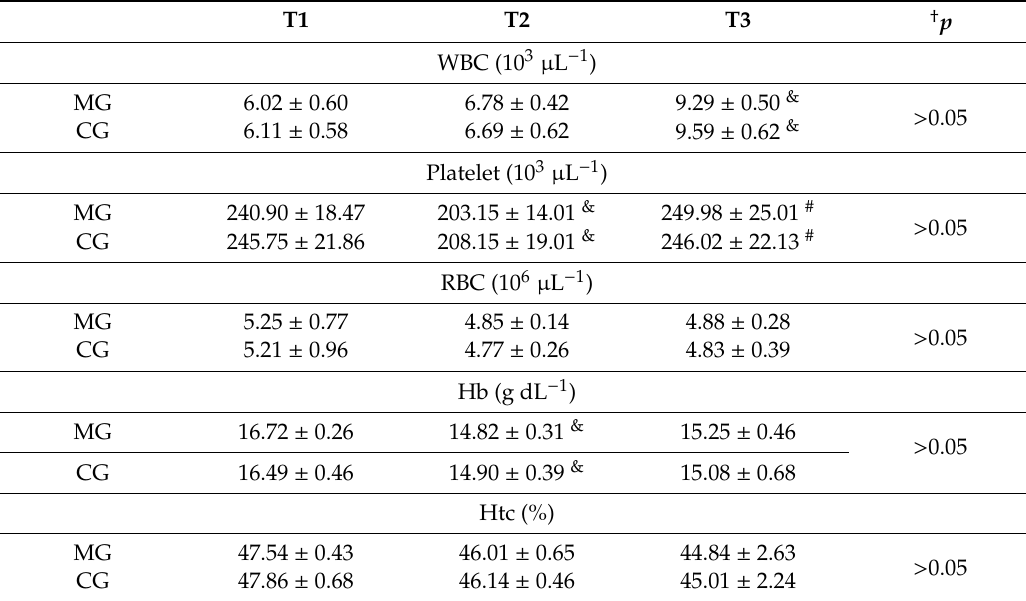
Table 3. Hematological parameters of the magnesium group (MG) and control group (CG) at the beginning (T1), half race (T2) and end of the race (T3).